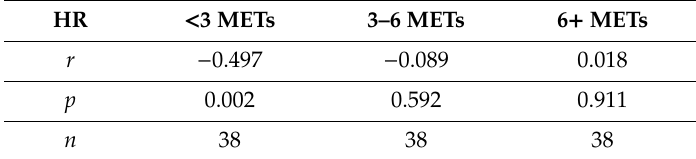
Table 4. Pearson correlations between HR and METs of low-intensity session. HR < 3